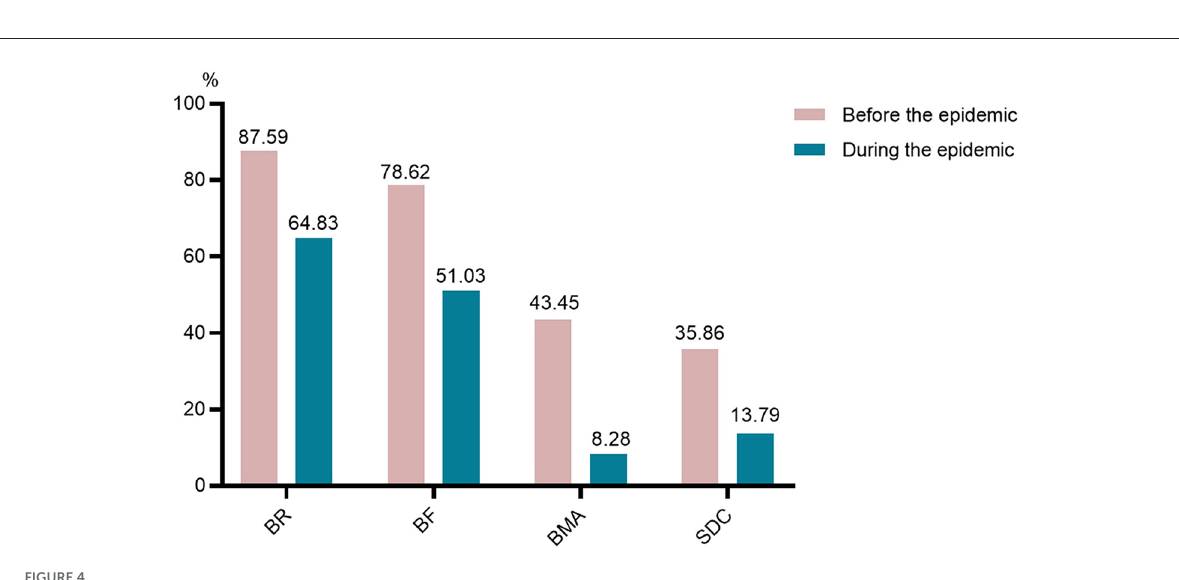
FIGURE4 Changes of regular re-examinations. BR, blood routine; BF, biochemical function; BMA, bone marrow aspiration; SDC, serum drug concentration of cyclosporine or